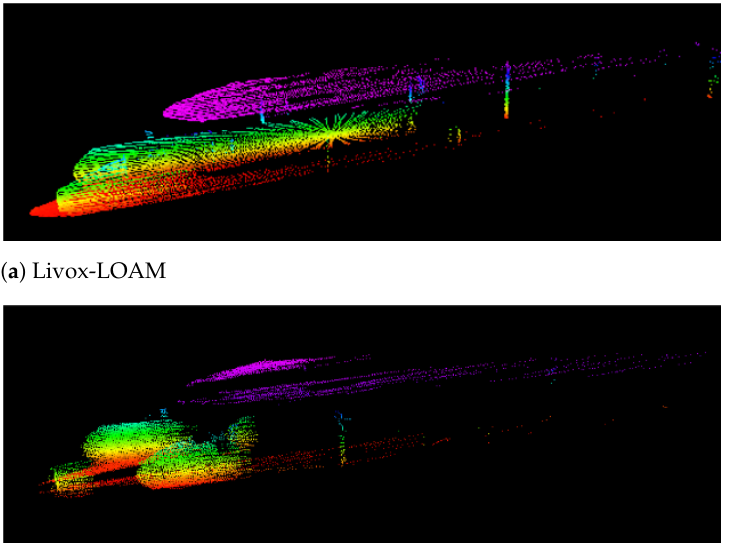
Figure 8. Compare corner feature collection between the proposed algorithm and Livox-LOAM in 10 scan frames.